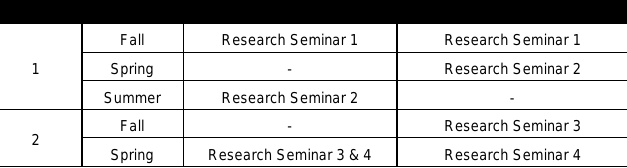
Table 1. The Course Sequence of when the Research Seminar Series Courses are Offered in the Program’s Previous Iteration Versus the Newly Redesigned Course